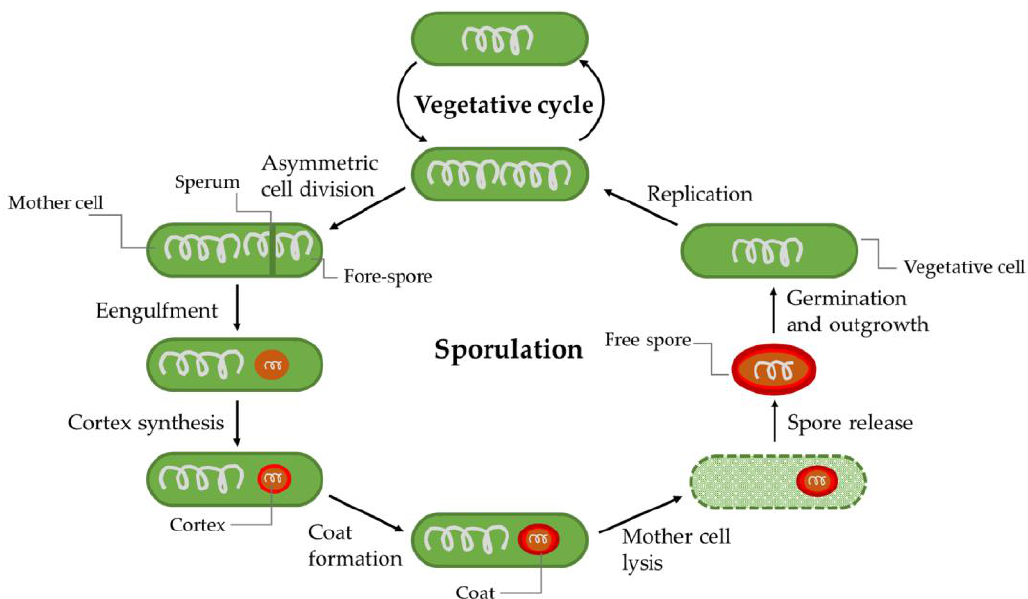
Figure 5. Model of the vegetative cycle and sporulation, germination, and outgrowth of B. cereus . Under severe stress conditions, B. cereus can initiate a sporulation process and form spores. Under favorable conditions, the spore can germinate and grow out to vegetative cells [56].